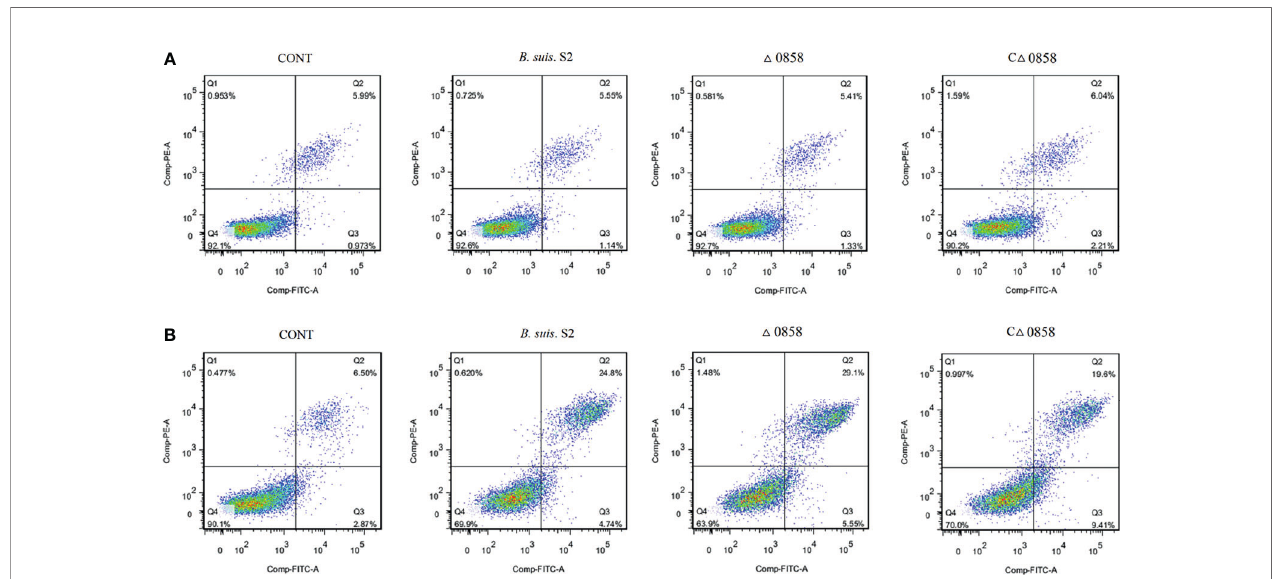
FIGURE 2 | Representative fl ow cytometry dot plots of apoptosis by Annexin V/PE staining. (A) The apoptosis of wild-type B. suis S2, BSS2_II0858 mutant, and complementation strain-infected RAW 264.7 were assayed using Annexin V/PE staining after a 24-h challenge. (B) The apoptosis of wild-type B. suis S2, BSS2_II0858 mutant, and complementation strain-infected RAW 264.7 were assayed using Annexin V/PE staining after a 48-h challenge. The results are expressed from 3 independent experiments.